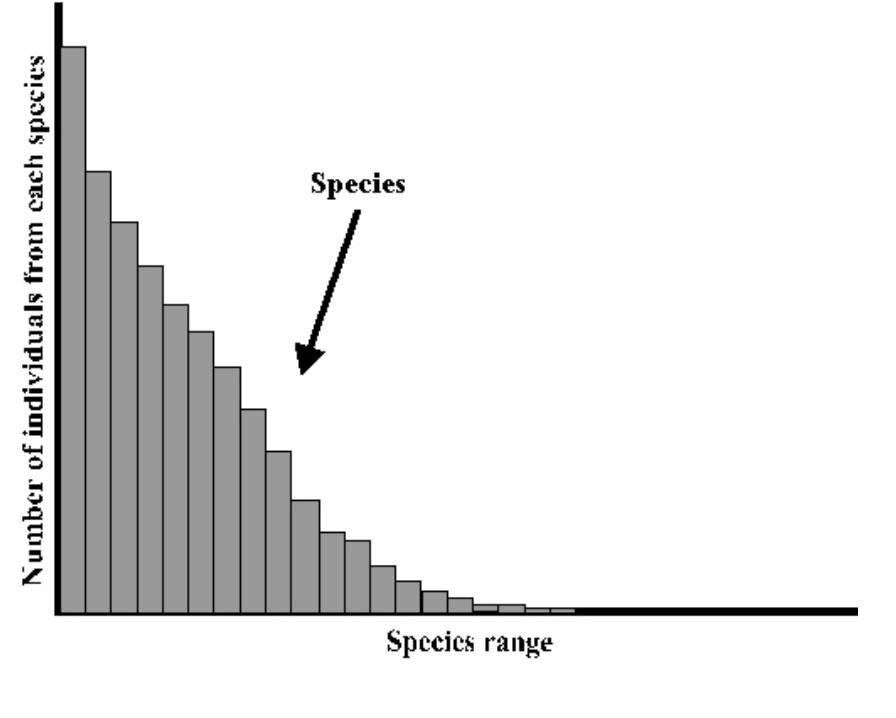
FIGURE 1. In a random sample, species can usually be ranged as a function of the number of individuals representing